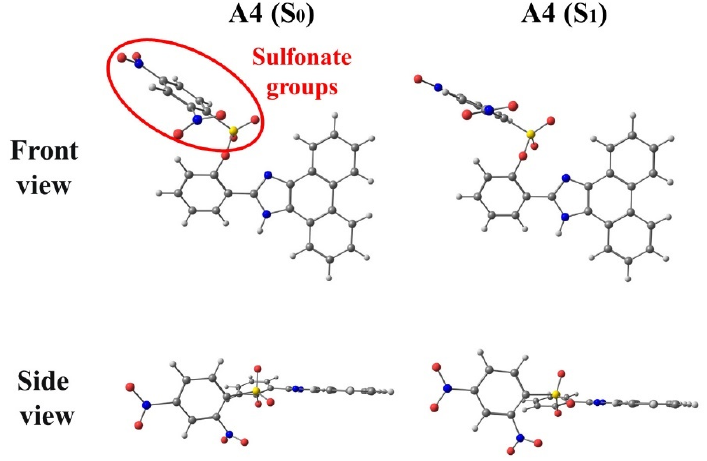
Figure 1. B3LYP-D3/TZVP/IEFPCM-optimized geometries of A4 in the S 0 and S 1 state.